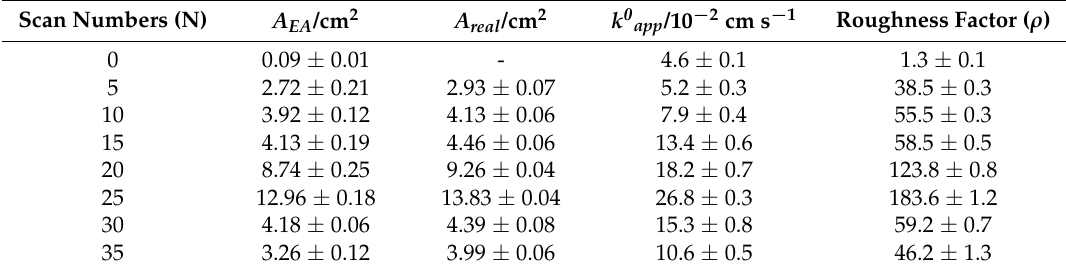
Figure 2. Cyclic voltammograms of AuNPs modified GCE electrodes with different number of scans (from 0 scans to 35 scans) in 0.5 M H 2 SO 4 . Scan rate 100 mV s − 1 . T = 25 °C. Table 1. Characterization of AuNPs on GC modified electrodes for different numbers of cyclic scans (N) during the electrodeposition step. Experimental conditions: 10 mM Fe(CN) 6 3 − /4 − in 50 mM TRIS buffer pH 7.4 with 0.1 M KCl for electroactive area ( A EA ), real surface area ( A real ), electron transfer rate constant ( k 0 ) and roughness factor ( ρ ) determination; 0.5 M H 2 SO 4 at a scan rate of 100 mV s − 1 , for A real